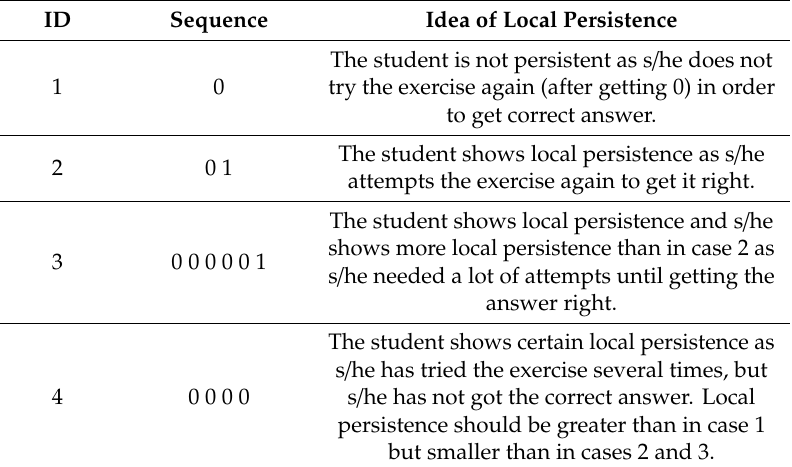
Table 2. Sequence of attempts of di ff erence